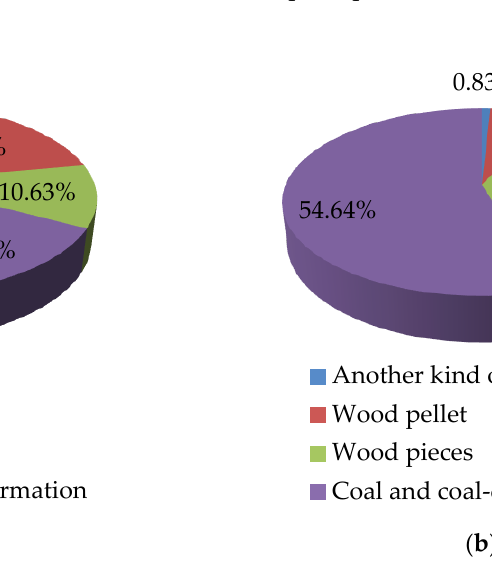
Figure 7. Boiler fuels divided by: ( a ) boiler class; ( b ) kind of fuel. Own research based on [60].